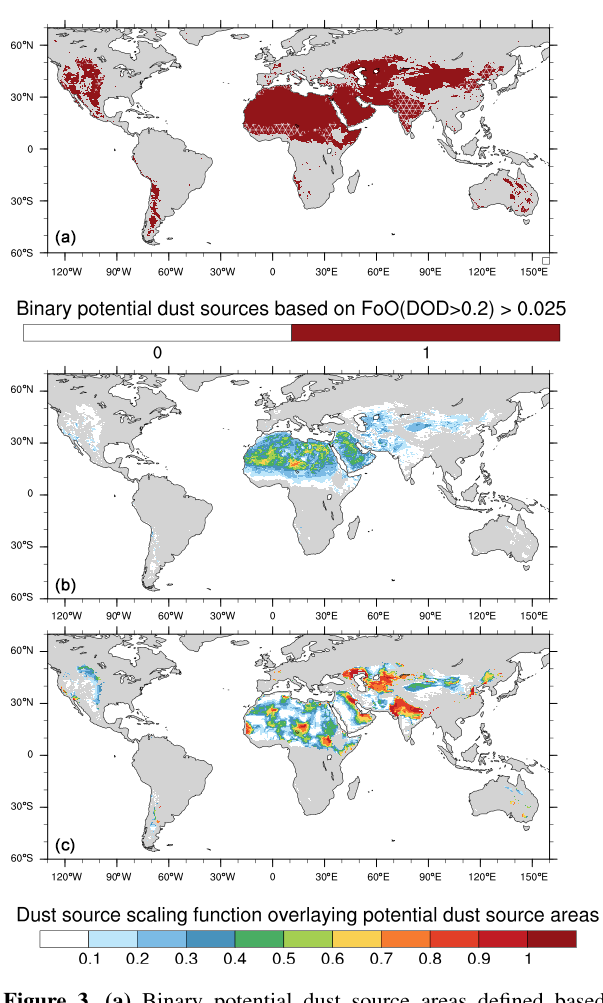
Figure 3. (a) Binary potential dust source areas defined based on FoO ( DOD > 0 . 2 ) > 0 . 025; light line patterns indicate anthro- pogenic dust sources using the method from Ginoux et al. (2012) considering cropland and pasture based on Klein Goldewijk et al. (2017); (b) binary dust source overlaid with FoO(DOD > 0 . 2); (c) binary dust sources overlaid with the topographic source scal- ing function from Ginoux et al. (2001) without vegetation